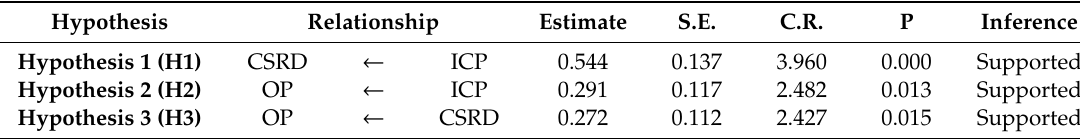
Table 4. Structural coe ffi cients ( β ) of the proposed